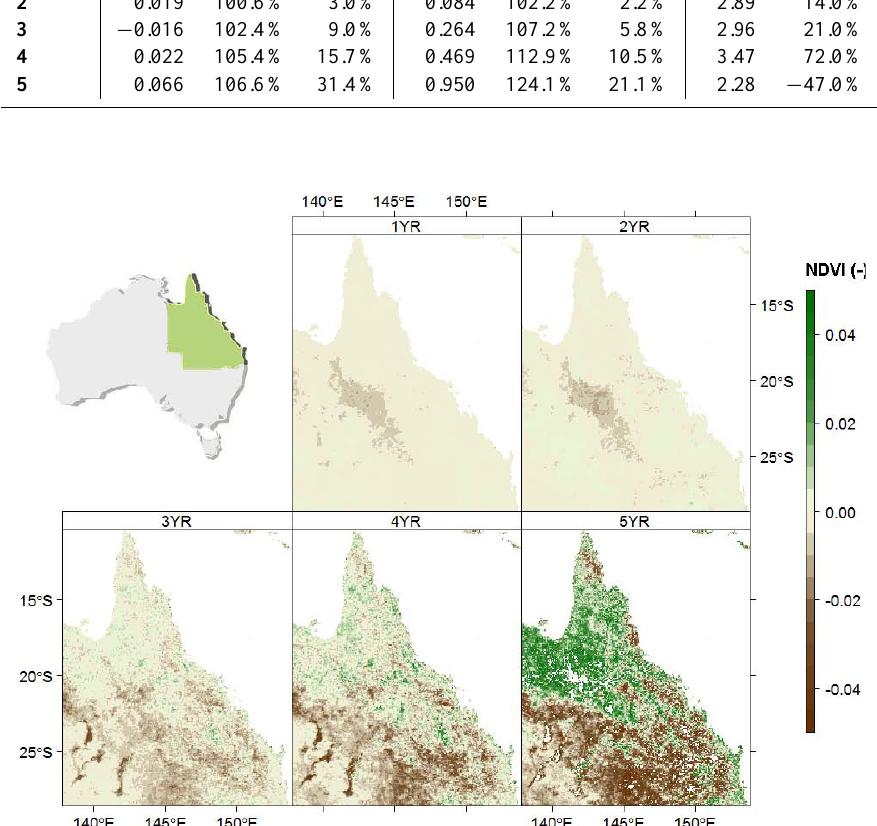
Fig. 4. Detected changes in NDVI for different levels of temporal aggregation – example for Queensland (Australia). The top-left map shows the location of Queensland and the 5 panels show the change in NDVI with respect to changes found using seasonal adjustedment without temporal aggregation. The aggregation levels correspond to 1, 2, 3, 4 and 5yr (YR)